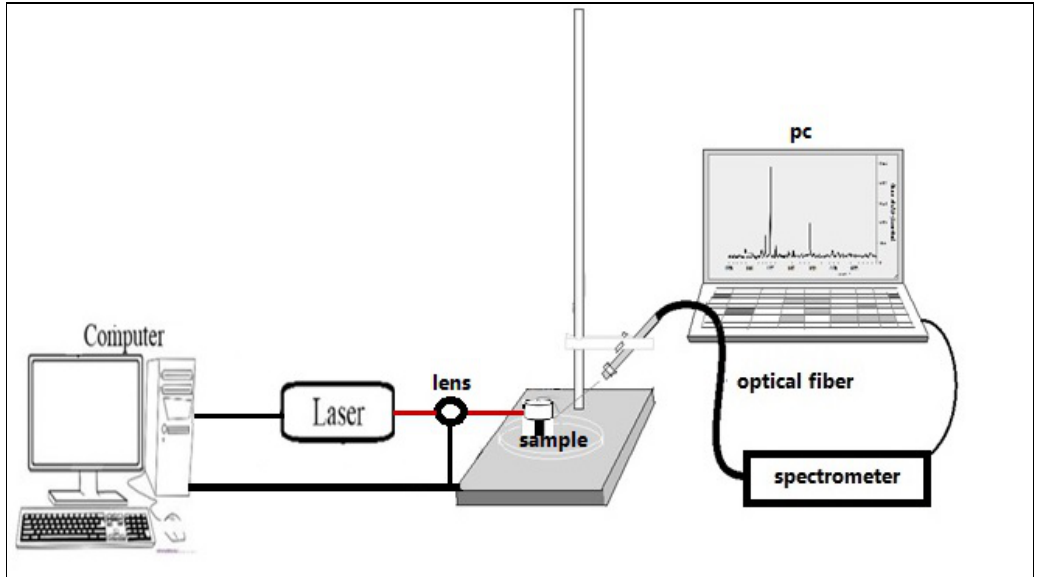
Fig.1: Schematic diagram of the experimental setup for laser induced